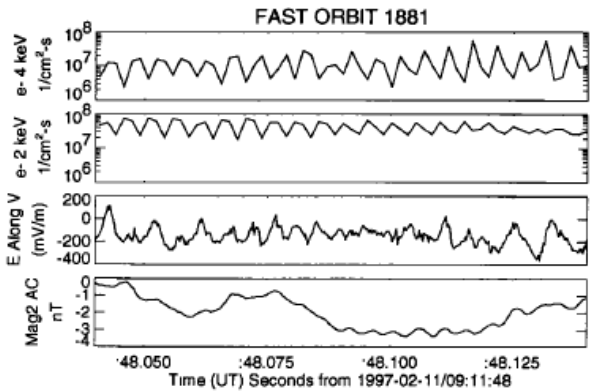
Fig. 1. Direct FAST satellite observation at the crossing of an au- Figure 1. Direct FAST satellite observation at the crossing of auroral arc, measuring energetic roral arc, measuring energetic electron fluxes and components of electron fluxes and components of electric and magnetic fields (McFadden et al, 1998). electric and magnetic fields (McFadden et al.,